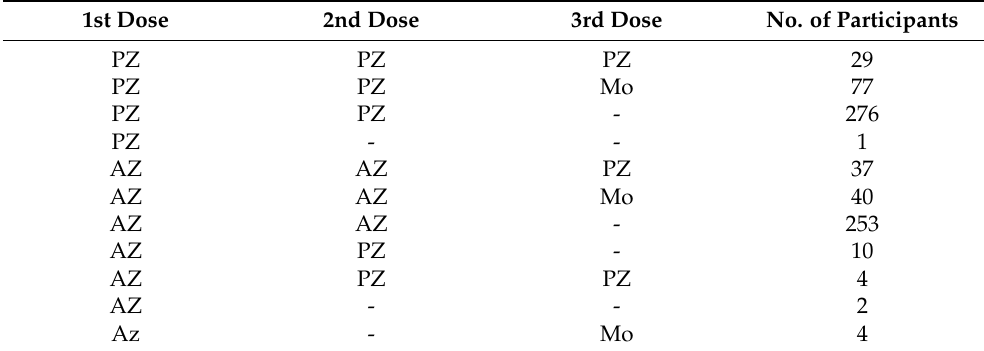
Table 1. Vaccine schedule of the 733 participants. 1st Dose 2nd Dose 3rd Dose No. of